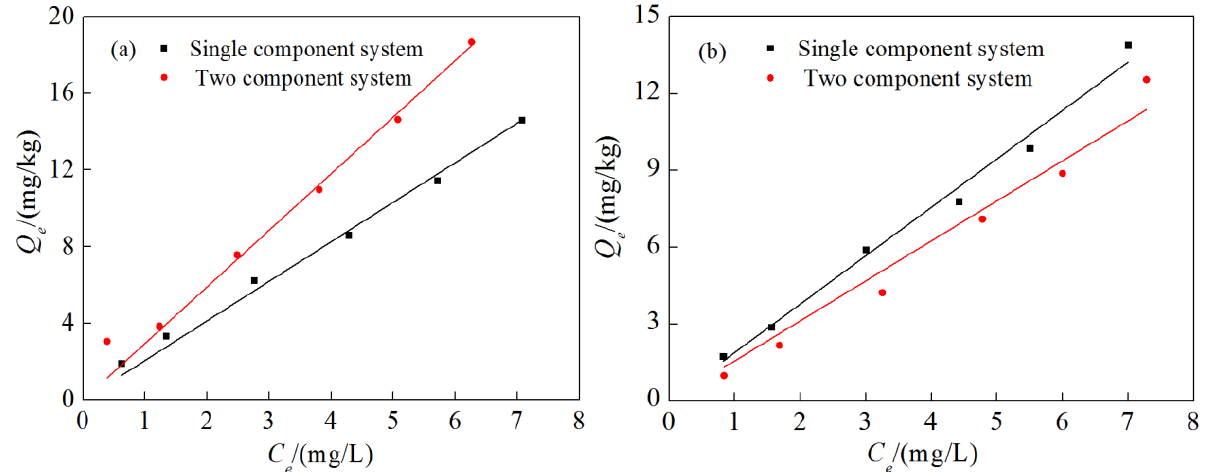
Figure 3. Competitive adsorption of benzene and toluene on the aquifer medium. (The initial concentration of the target compound was 1, 2, 4, 6, 8, and 10 mg/L, and the concentration of the coexisting solute was 2 mg/L). ( a ) Effect of benzene on the adsorption of toluene on the aquifer medium; ( b ) Effect of toluene on the adsorption of benzene on the aquifer medium.